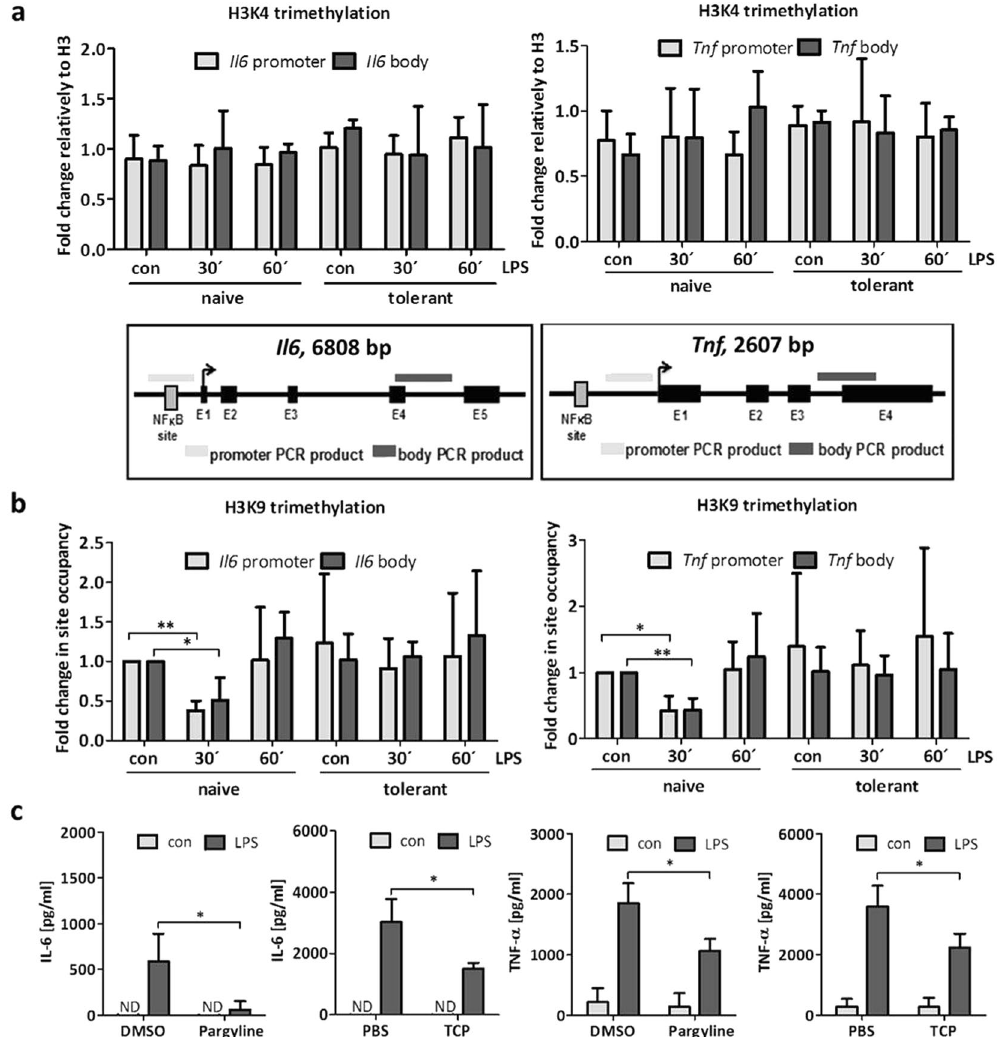
Figure 2. Histone H3K9 trimethylation is reduced in stimulated naive BMMCs and inhibition of histone demethylation leads to reduced cytokine production. BMMCs were pretreated with LPS (300 ng/ml) for 24 h to induce ET. To analyse histone modifications in naive and tolerant cells, the cells were stimulated with LPS (1 µ g/ml) for 30 min and 60 min and ChIP analysis was performed. Fold change in site occupancy of H3K4me3 ( a ) and H3K9me3 ( b ) at the Il6 and Tnf gene was measured. Data show mean ± SD from n = 3 independent experiments. Two-sided ANOVA with Tukey HSD post-hoc test and one-sample t -Test were performed to calculate the p-values. Multiple testing p-values were corrected by FDR. Localisation of PCR products within the Il6 gene and the Tnf gene are depicted. Furthermore, cells were incubated with the LSD1 inhibitors Pargyline (1000 µ M) or TCP (250 µ M) for 2 h and stimulated with LPS (2 µ g/ml) for 4 h to analyse protein production of IL-6 and TNF- α ( c ). Data show mean ± SD from n = 3 independent experiments with three biological samples. Student’s t -Test was performed to calculate the p-values. * p < 0.05, ** p < 0.01, *** p <